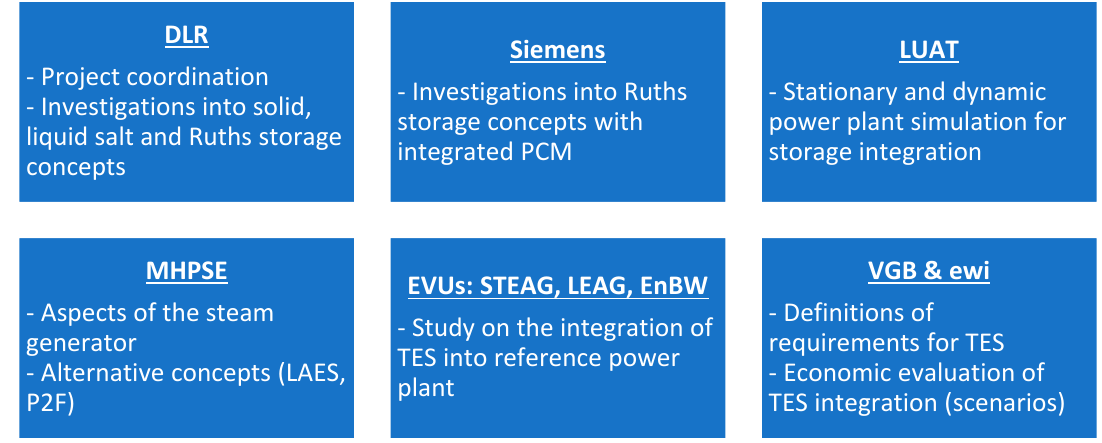
Figure 1. Project partners and work contents in the joint project FLEXI-